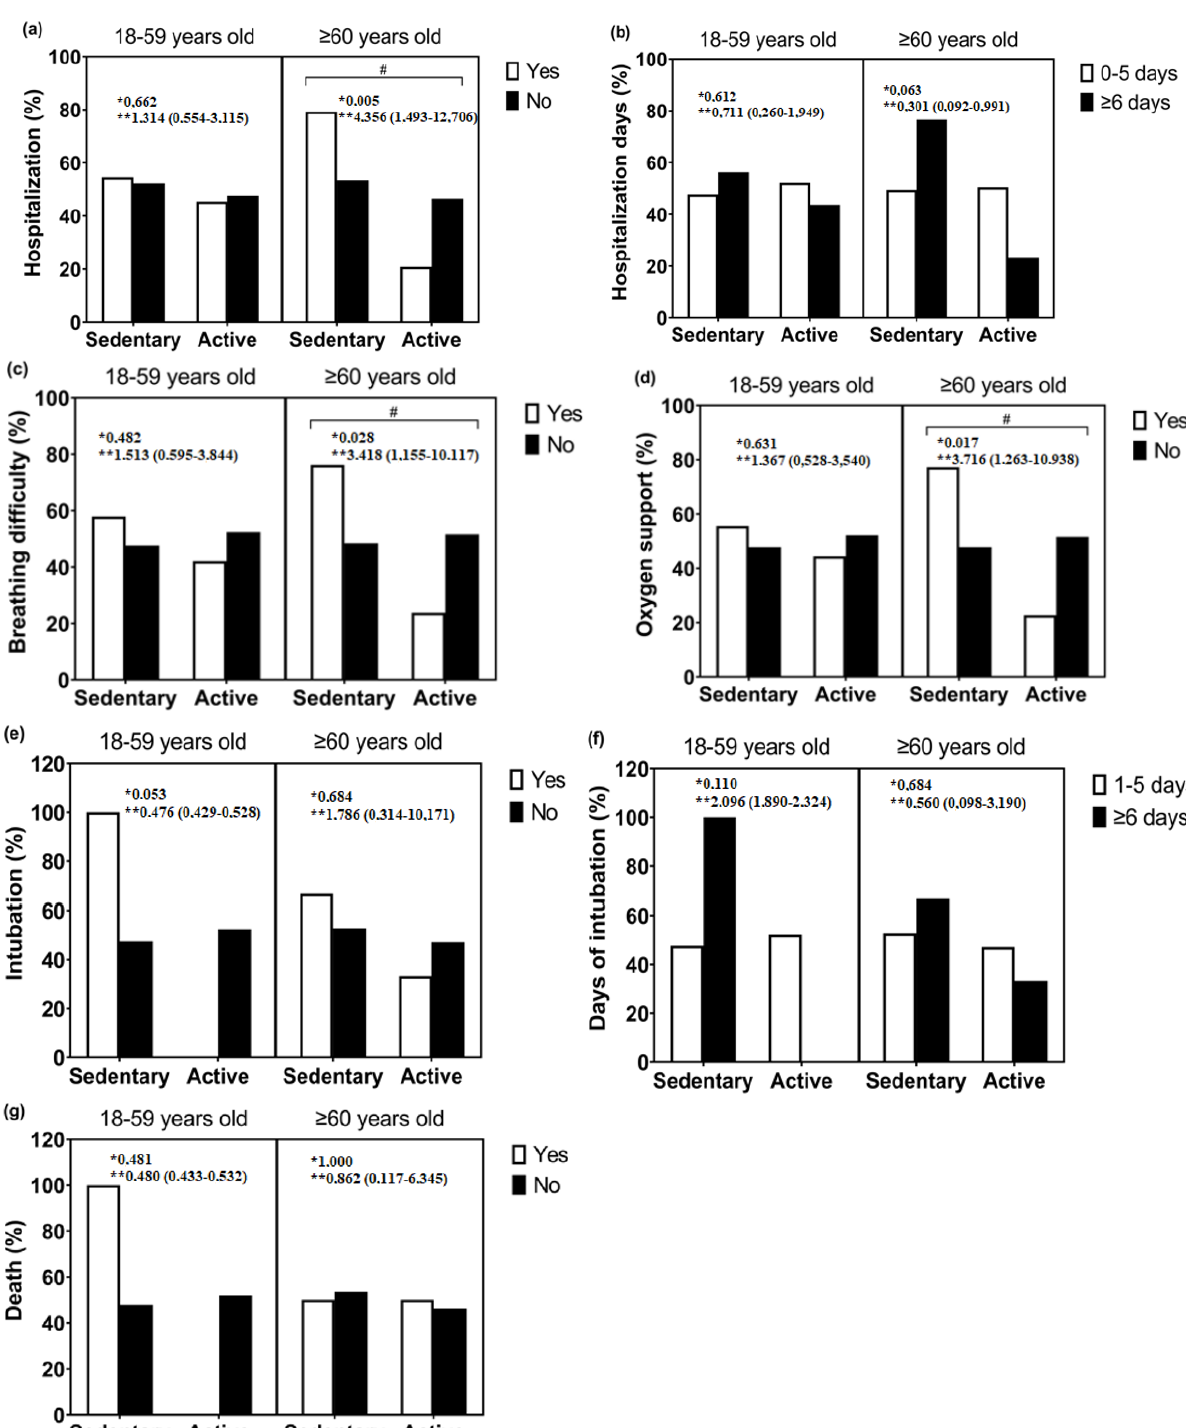
Figure 2. Association between sedentary and active groups, age groups of 18 to 59 years and 60 years and over, and clinical outcomes of COVID-19; ( a ) hospitalization; ( b ) hospitalization days; ( c ) breathing difficulty; ( d ) oxygen support; ( e ) intubation; ( f ) intubation days; ( g ) death. * p value; ** OR (IC 95%); #: significant difference between sedentary and active. After analyzing the binary logistic regression, controlling for confounding variables, it was observed that physically active people had a lower chance of hospitalization (OR 0.440; 95% CI 0.225–0.861; p = 0.017), hospitalization days (OR 0.461; CI 95% 0.212–1.000; p =